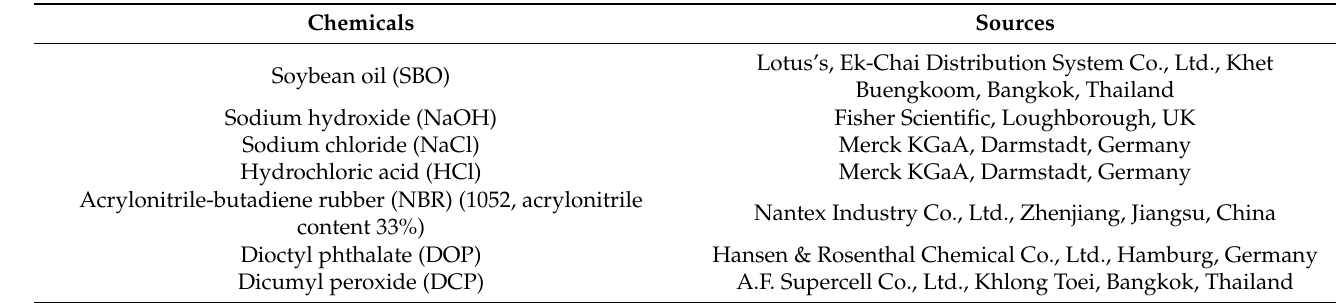
Table 1. Characteristic and sources of the chemicals